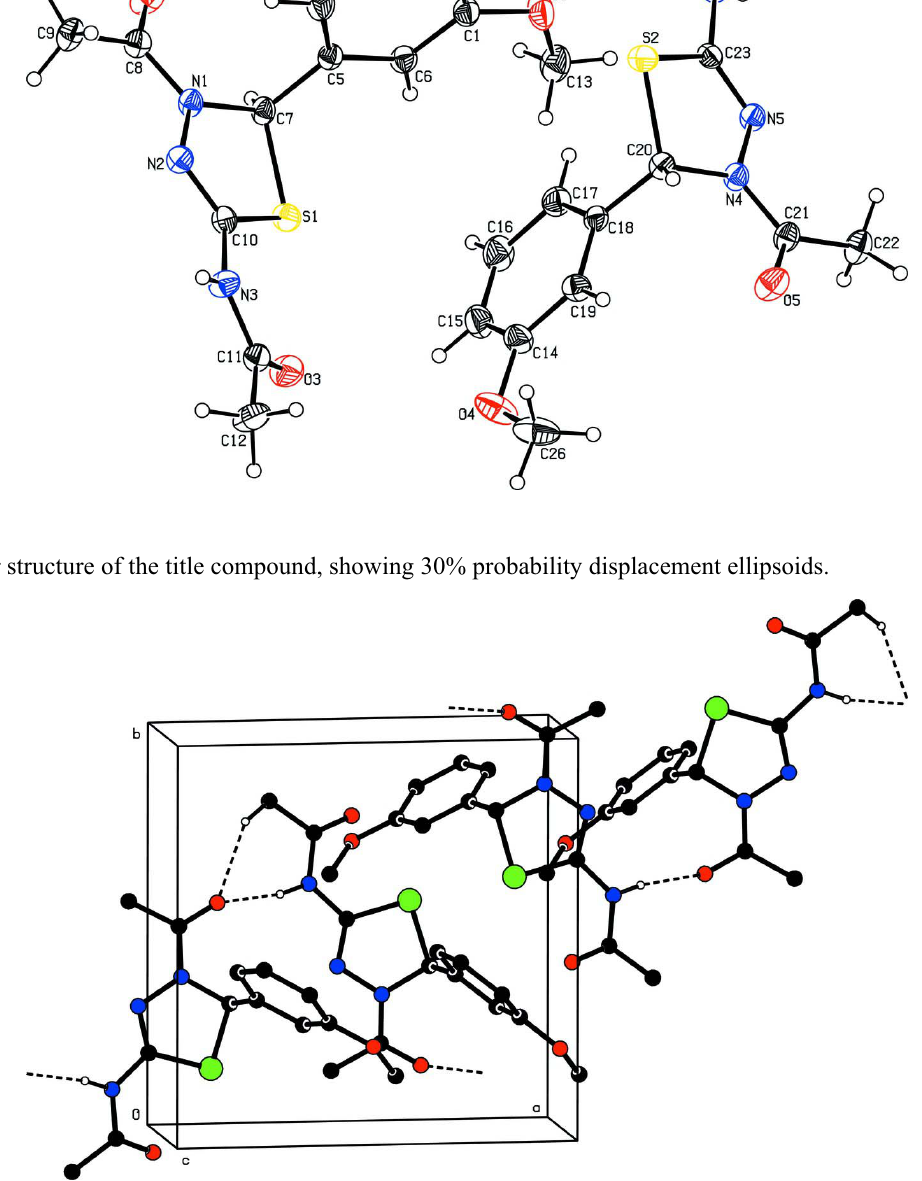
Figure 2 The molecular packing of the title compound. For clarity, hydrogen atoms which are not involved in hydrogen bonding were